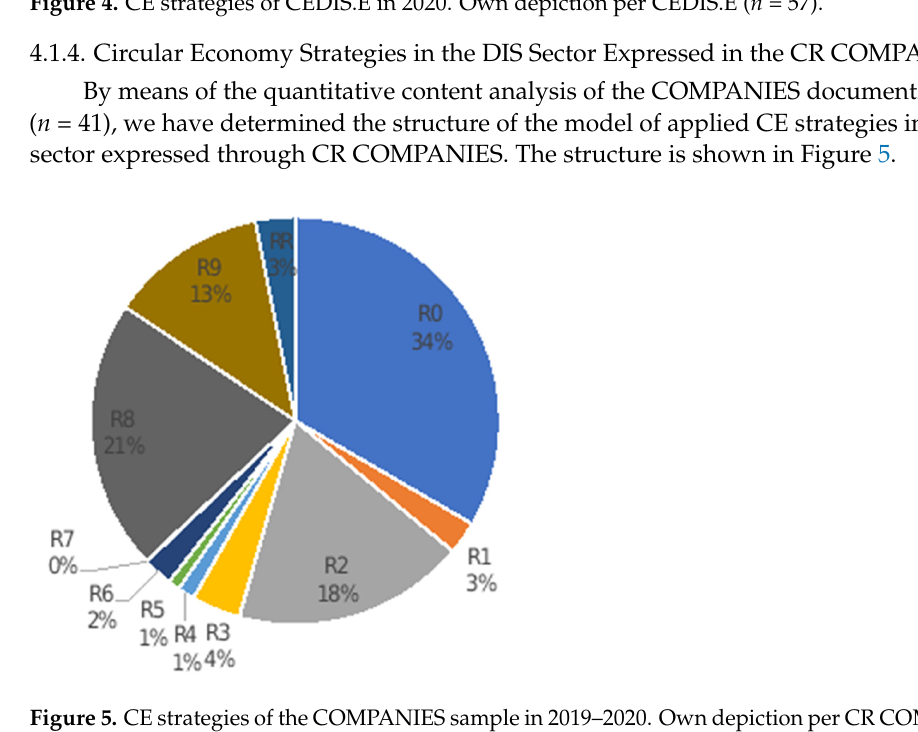
Figure 5. CE strategies of the COMPANIES sample in 2019–2020. Own depiction per CR COMPANIES (n = 41).